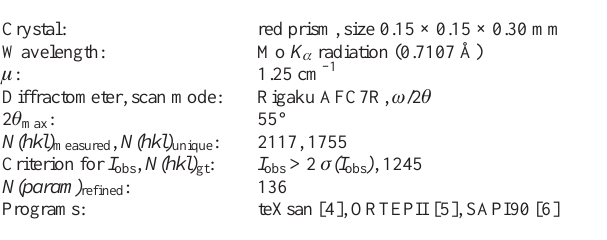
Table 1. Data collection and handling.